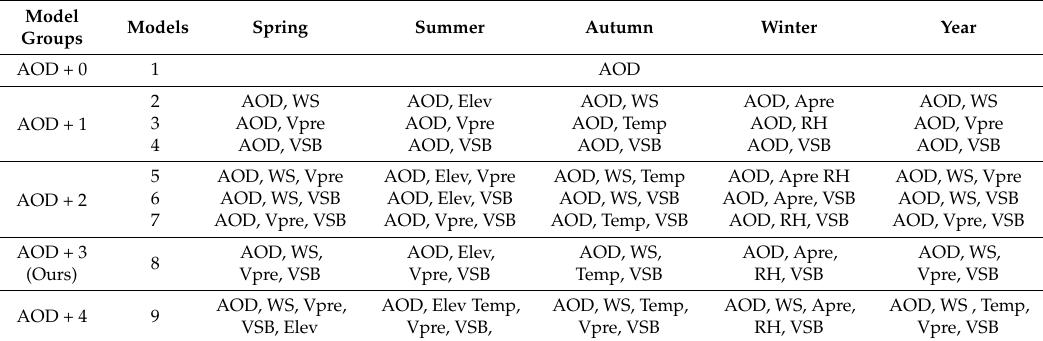
Table 4. The list of all GWR models with different variable combinations.